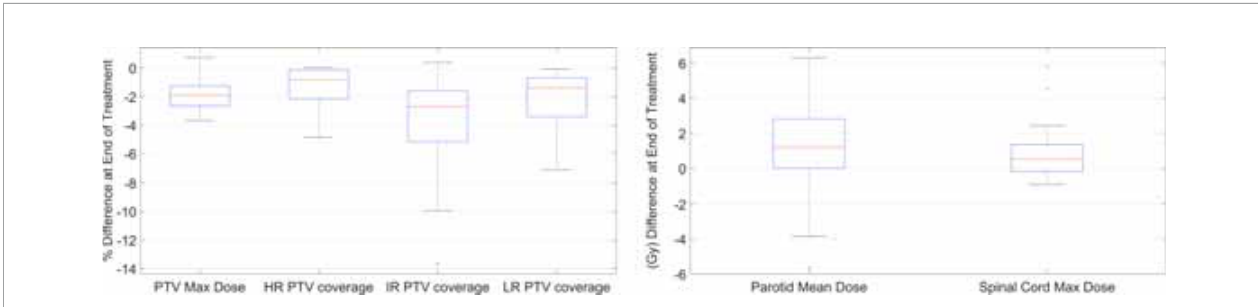
FIGURE 3 | Boxplot summary of the DP values differences between start and end of treatment for PTVs, PGs, and spinal